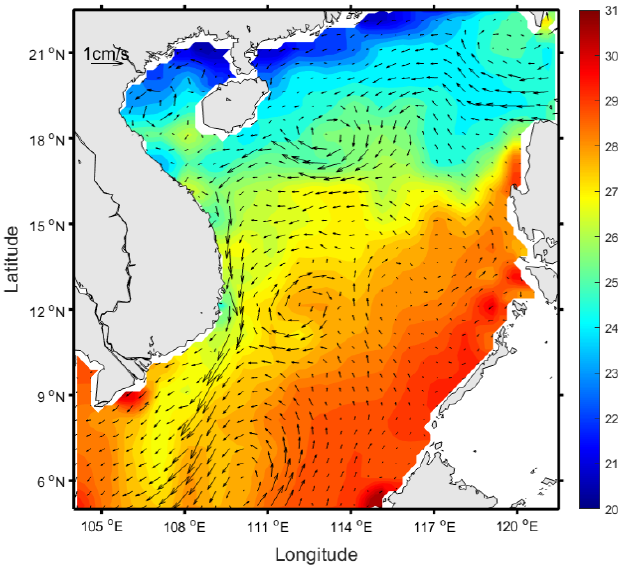
Figure 11. Inverted sea surface temperature distribution (unit: ° C ) and surface flow field.